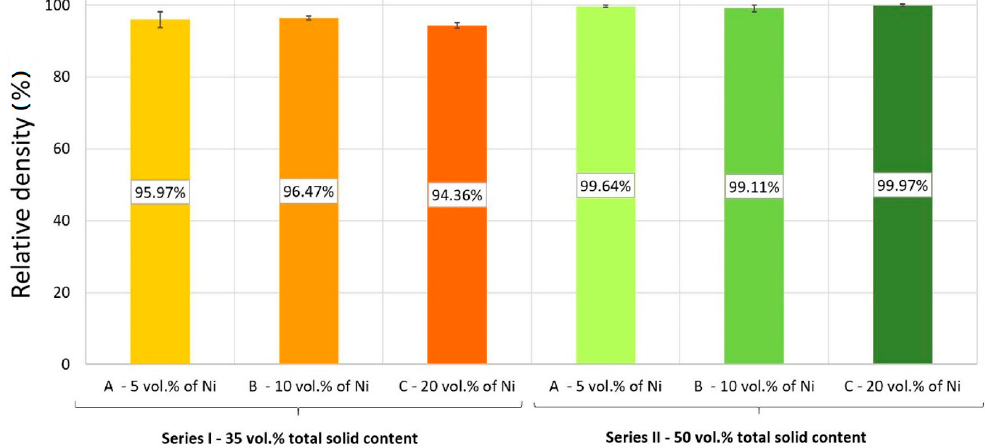
Figure 9. Values of the relative density of produced composites.